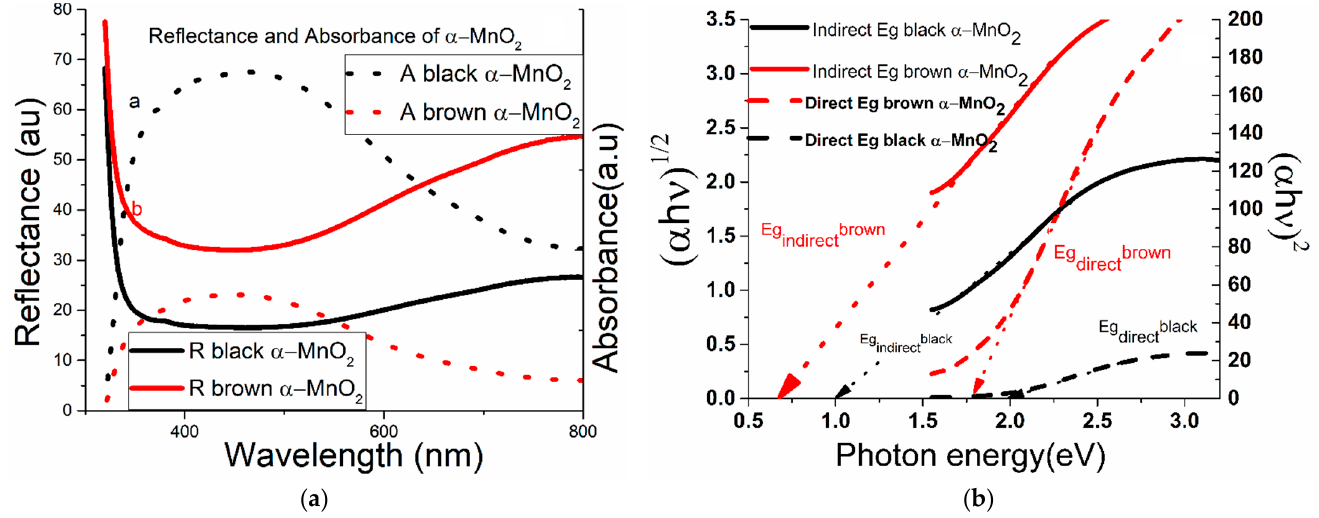
Figure 4. ( a )—Diffuse reflectance and absorbance spectra vs. wavelength, recorded for the black (a) and the brown α -MnO 2 (b). ( b )—Plot of ( α h ν 2 and ( α h ν ) 1/2 vs. (h ν ) for the black and brown α -MnO 2 , with optical band gaps determination.